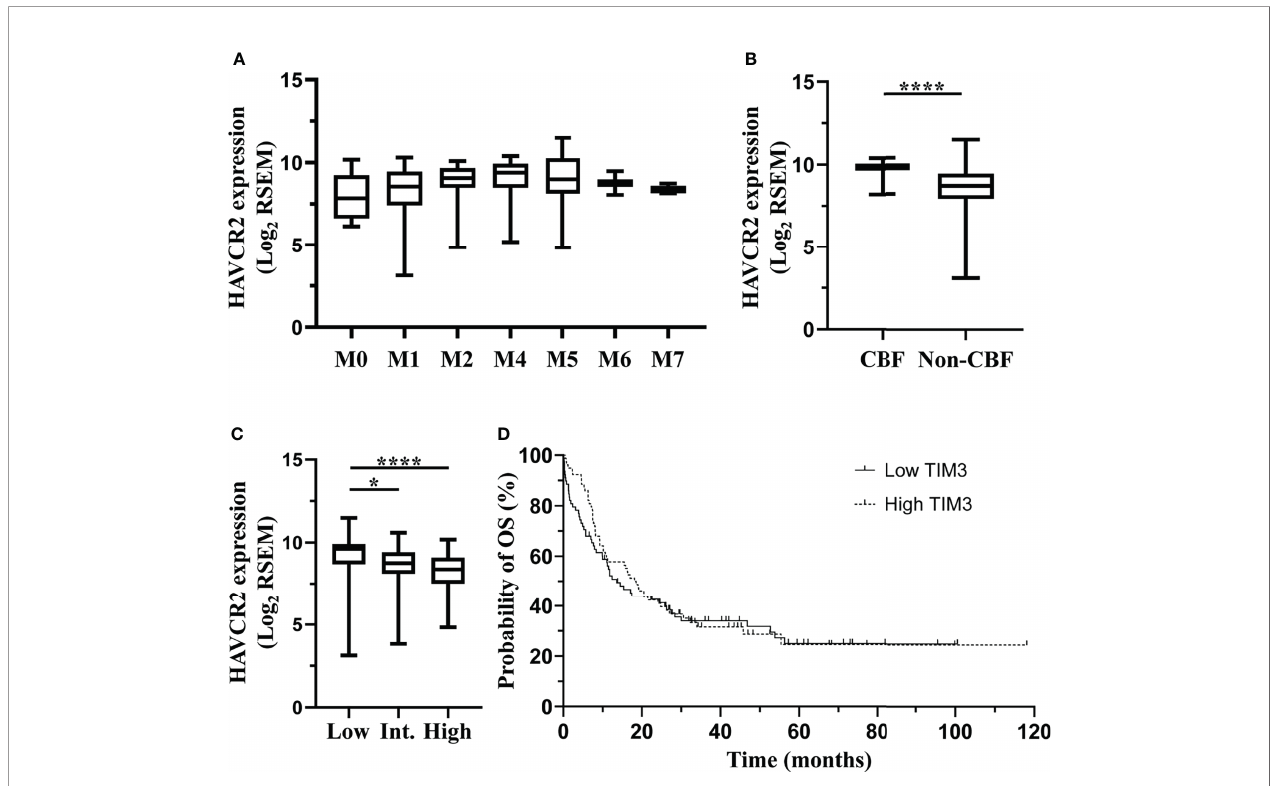
FIGURE 4 | TCGA dataset: associations of HAVCR2 mRNA expression level in the bone marrow of non-M3 AML patients with clinical parameters. Data of a cohort of 200 AML patients from The TCGA were downloaded via cBioPortal. Among them, 157 patients who were diagnosed with non-M3 AML and had data of HAVCR2 mRNA expression (RNA Seq V2 RSEM, log2-transformed) were analyzed in this study. HAVCR2 is the gene encoding TIM-3. HAVCR2 expression levels in FAB subtypes are shown in (A) . HAVCR2 expression levels in patients with or without CBF translocations are shown in (B) . HAVCR2 expression levels in ELN risk groups are shown in (C) . Patients were divided into low and high TIM-3 groups based on the median HAVCR2 expression level. Probabilities of OS of two groups are shown in (D) . Statistical signi fi cance is displayed as * p <0.05, **** p < 0.0001. CBF, core-binding factor; Int, intermediate; OS, overall